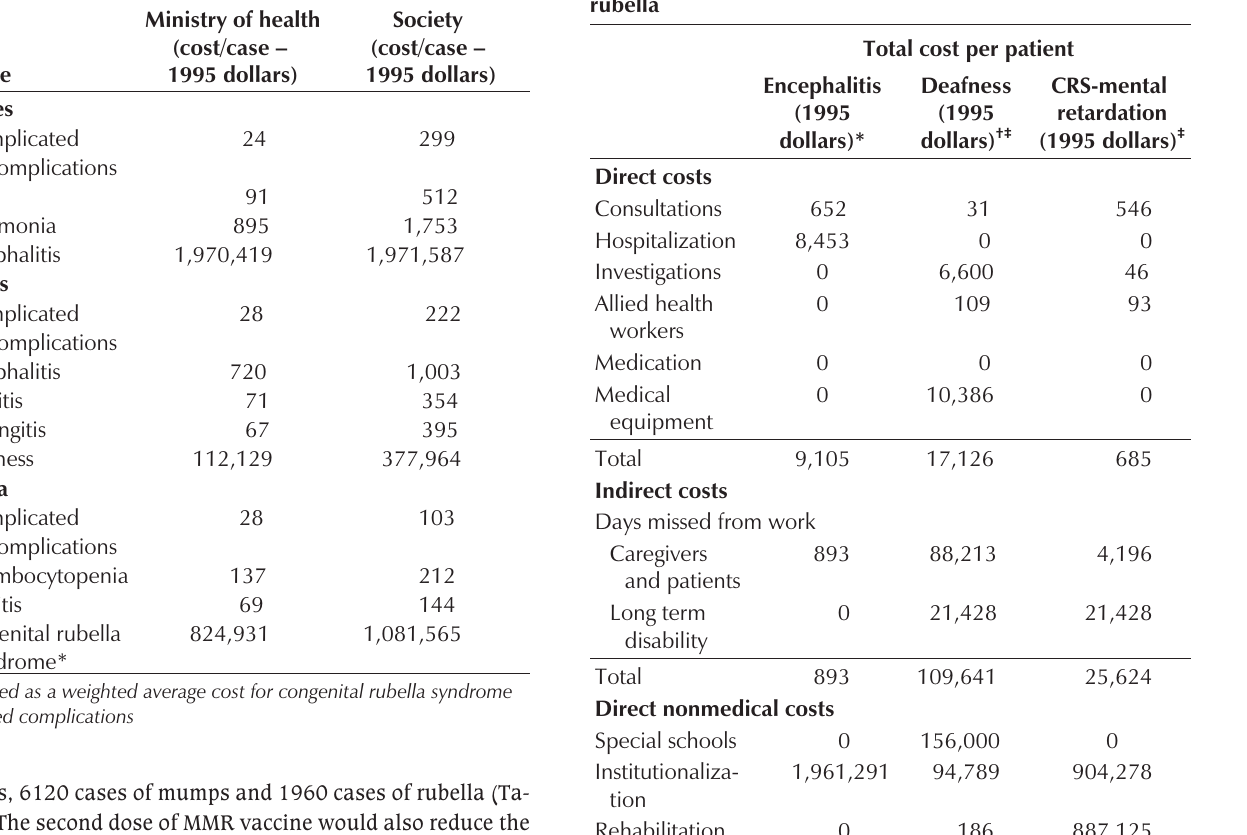
Estimated lifetime costs per measles, mumps or rubella case with and without complications